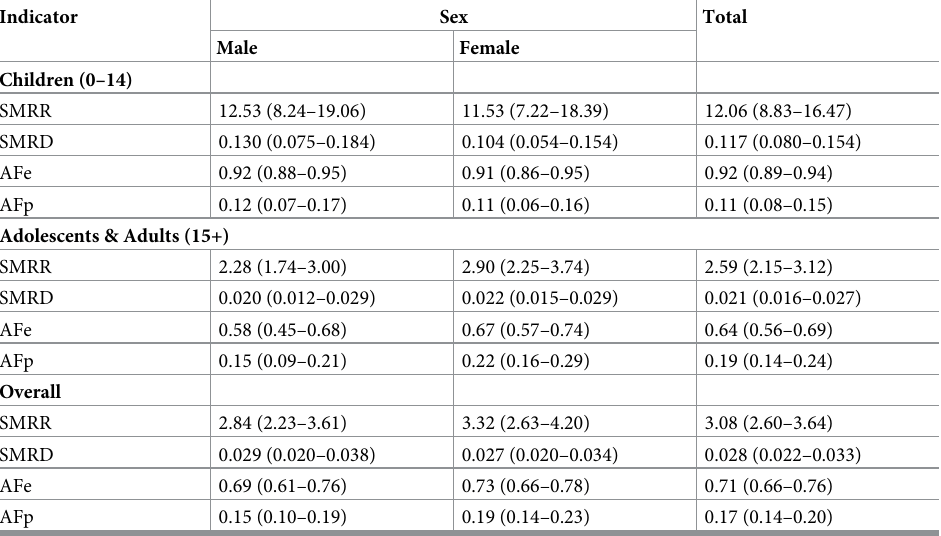
SMRR, standardized mortality rate ratio; SMRD, standardized mortality rate difference; AFe, attributable fraction in the exposed; AFp, population attributable